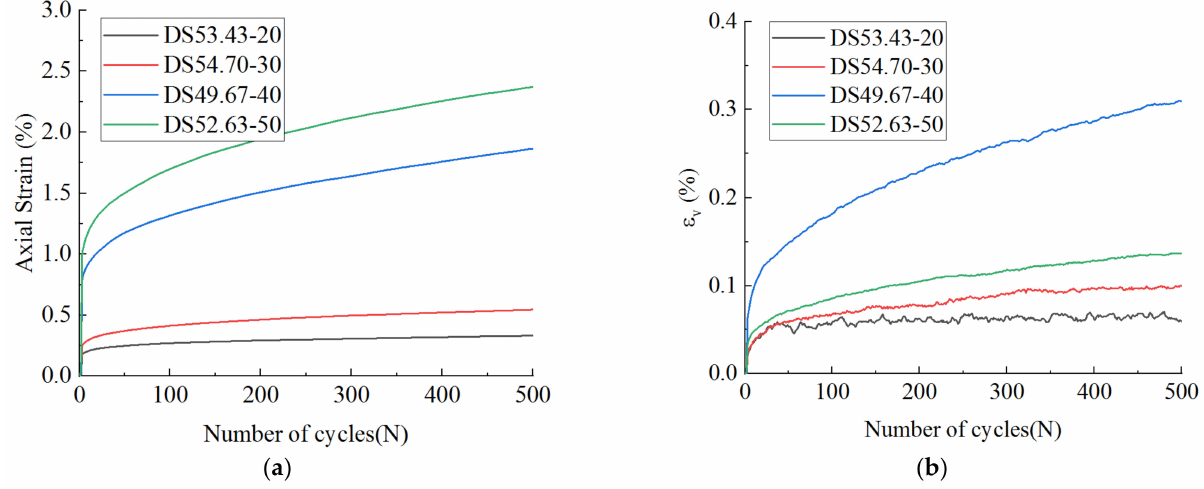
Figure 3. Axial ( a ) and volume ( b ) strain accumulated curves of moderately dense